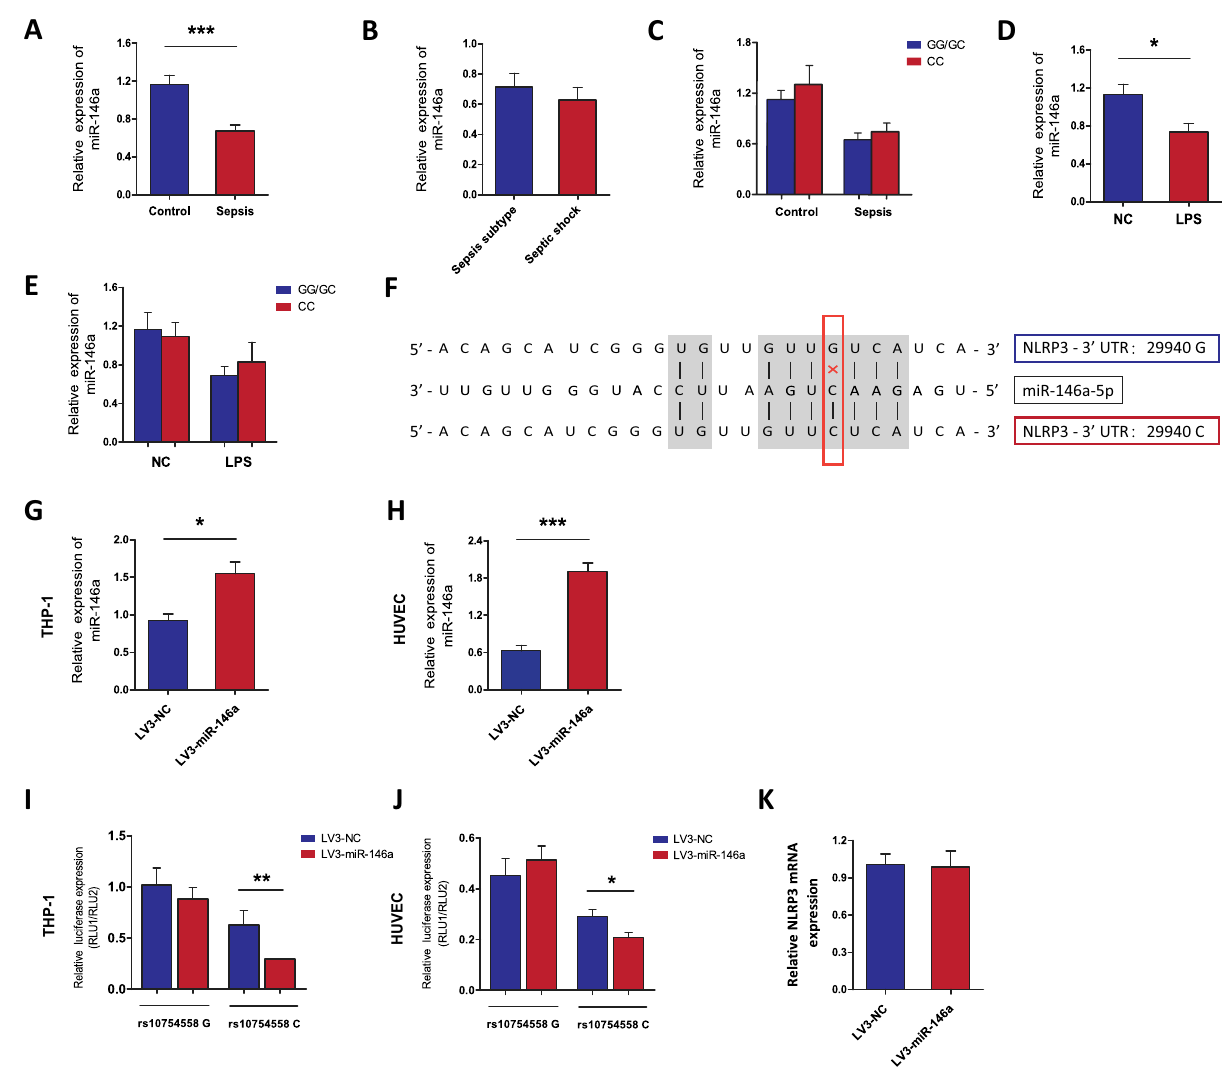
Figure 6. The NLRP3-29940G>C is a gain-of-function alteration causing suppression of NLRP3 expression via altering miR-146a-5p binding. ( A – C ) The miR-146a expression in septic patients (n = 50) and healthy controls (n = 50) with different rs10754558 polymorphism; ( D , E ) PBMCs isolated from 50 healthy subjects with different rs10754558 genotypes were stimulated with 500 ng/mL of LPS (n = 25) or PBS (n = 25) in vitro, and then miR- 146a expression was detected; ( F ) Bioinformatics predicted that the rs10754558 G-to-C mutation was located at the binding site between 3 ′ UTR of NLRP3 and miR-146a-5p; ( G , H ) HUVECs and THP-1 cells were infected by LV3-miR-146a (miR-146a overexpression) or LV3-NC, and the infection efficiency of LV3-miR-146a was determined by qRT-PCR analysis; ( I , J ) The effect of miR-146a on the transcriptional activities of